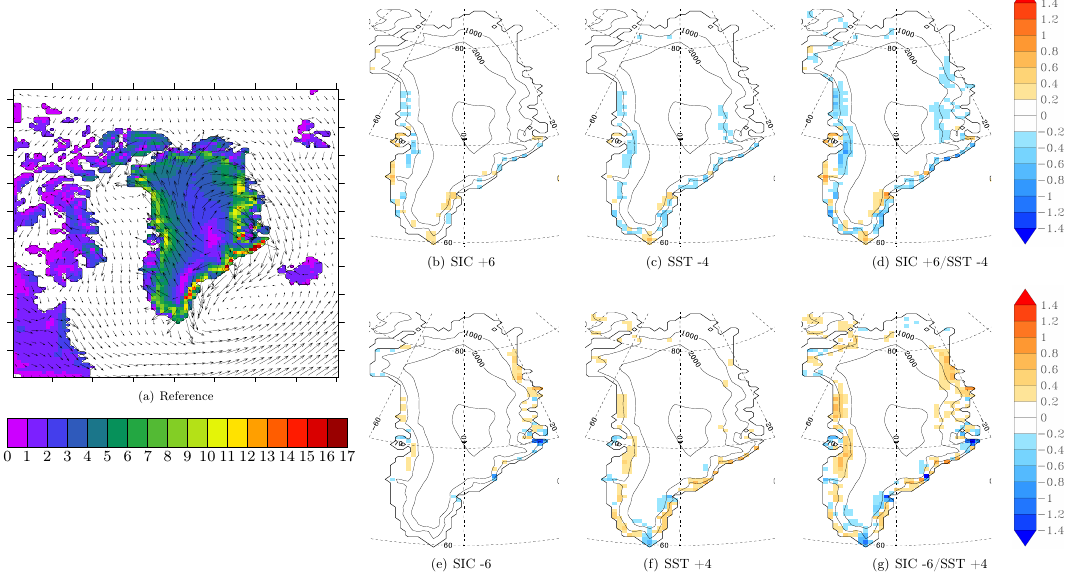
Figure 10. Annual mean wind speed (ms − 1 ) for the reference run (a) over 2007–2012. Difference in the annual mean wind speed (ms − 1 ) between (b) SIC + 6, (c) SST − 4, (d) SIC + 6/SST − 4, (e) SIC − 6, (f) SST + 4, (g) SIC − 6/SST + 4 experiments and the reference